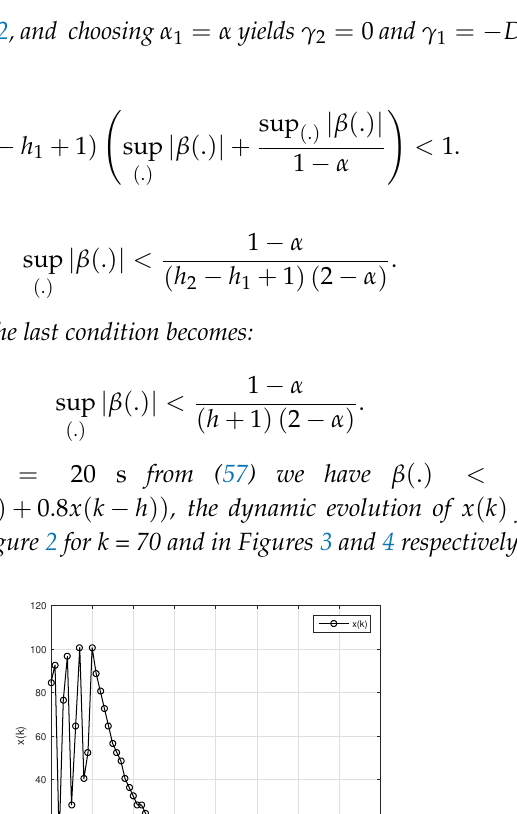
Figure 2. Dynamics evolution of x ( k ) for initial condition x ( k ) = 100